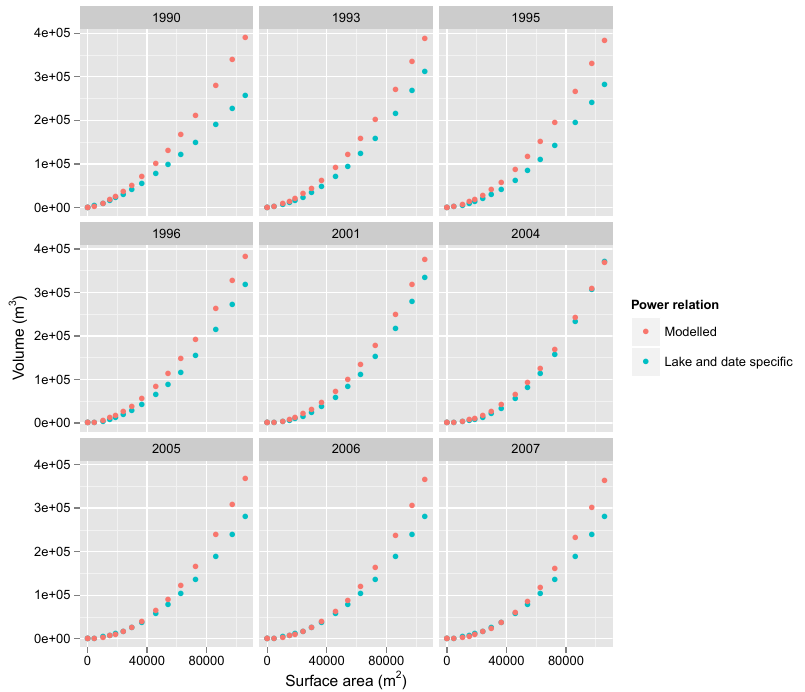
Figure 10. Lake- and date-specific surface-volume relation against the interSR power relation adapted for silting over time (lake